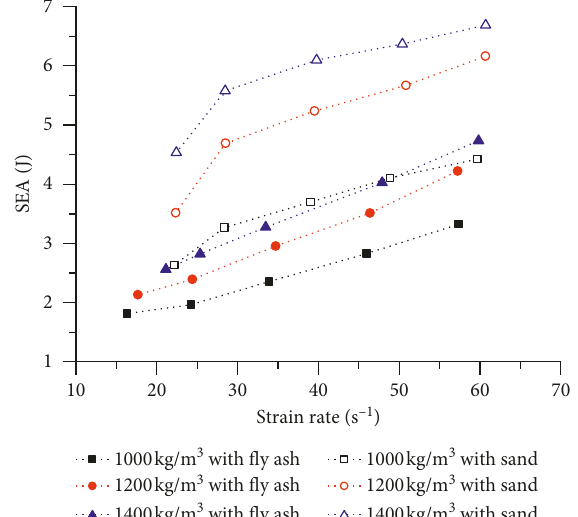
Figure 19: Relationship between the specific energy absorption (SEA) and the strain rate.